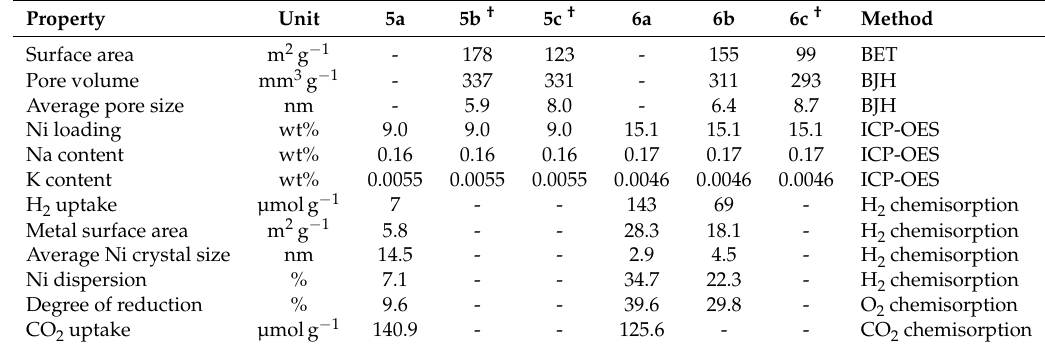
Table 2. Summary of the characterization results for the Ni/ γ -Al 2 O 3 catalysts. It was not possible to determine the NiO size for the alumina catalysts with XRD because only NiAl 2 O 4 was